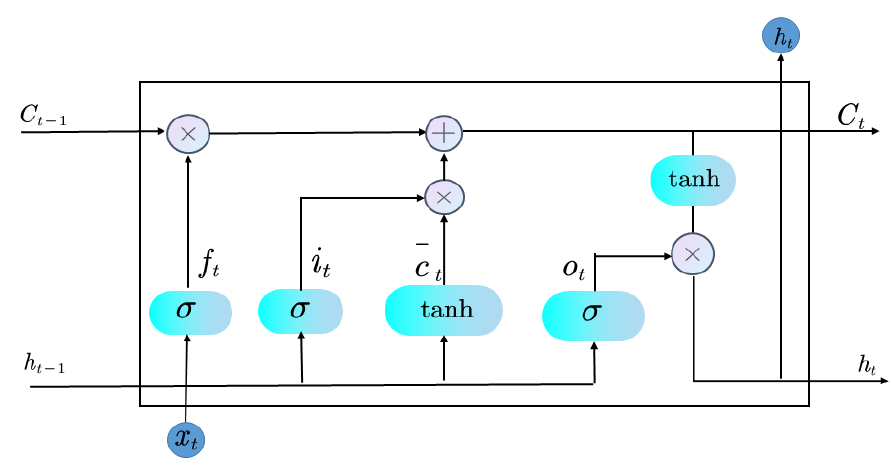
Figure 4. The operation flow chart of a long short-term memory network